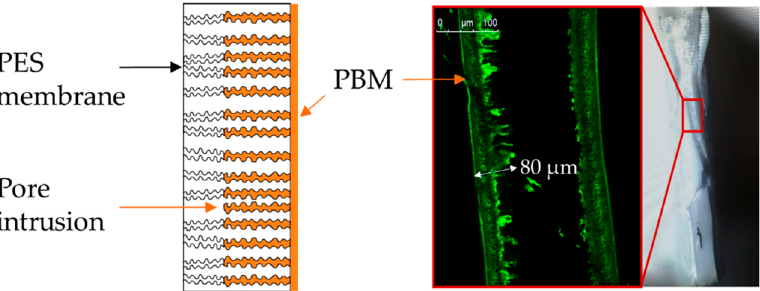
Figure 3. Confocal microscope tests revealing a high membrane pore intrusion level for the UV- LED − polymerized PBM-coated membrane, viewed in cross